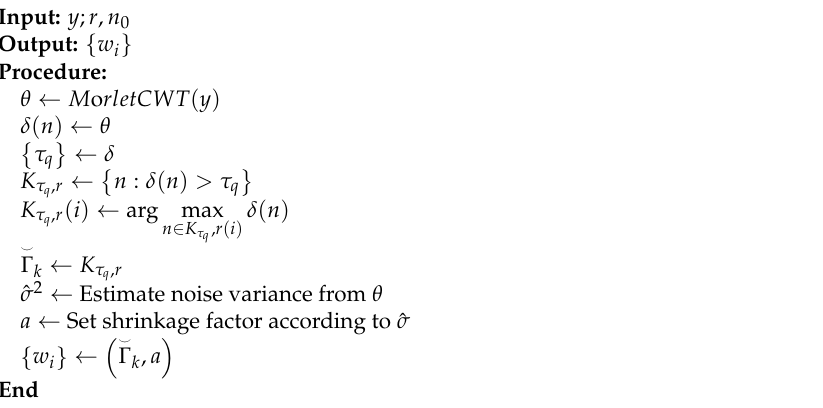
Algorithm 1: Determination of the set of positions K τ , r and adaptive weights { w i }